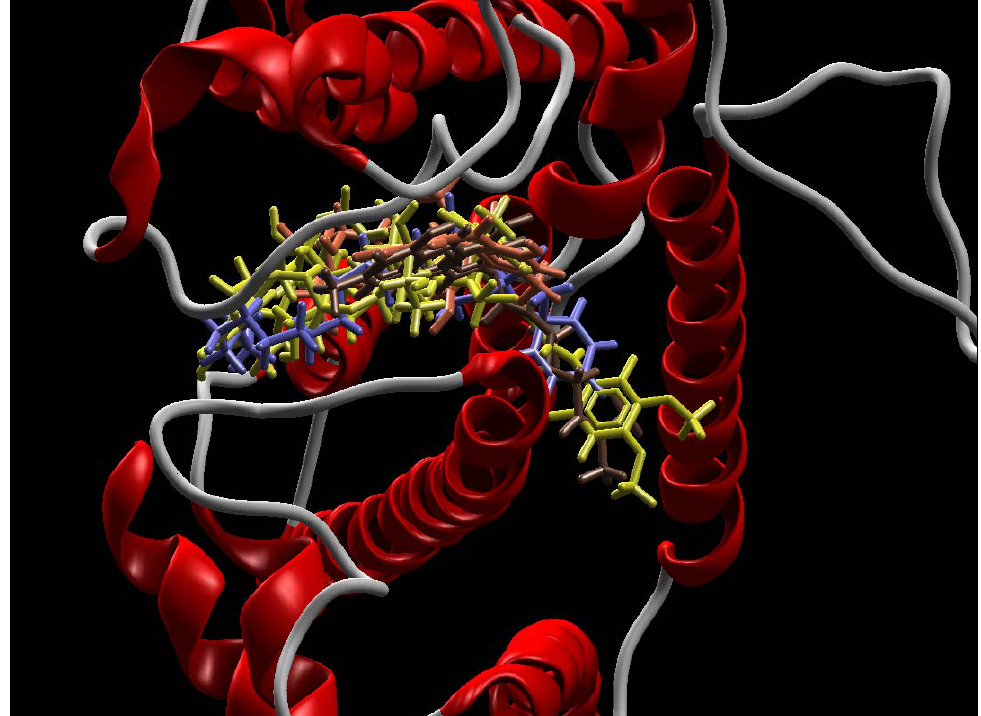
Supplementary Figure 5. Superposition of the five compounds with top poses (shown with different colors) docked to FDS, indicating similar binding mode.